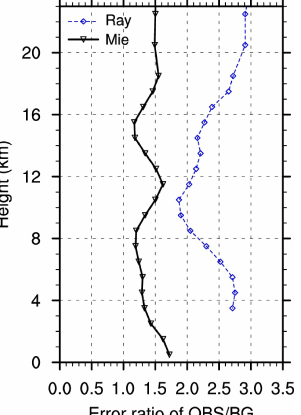
Figure 6. Vertical variation in the square root of the ratio of ran- dom error variance in Mie (solid black) and Rayleigh (dashed blue) winds versus FV3GFS winds. Results are based on global innovations from the BASE experiment using the Hollingsworth– Lonnberg method. The symbols are plotted at the average height of the observations in each